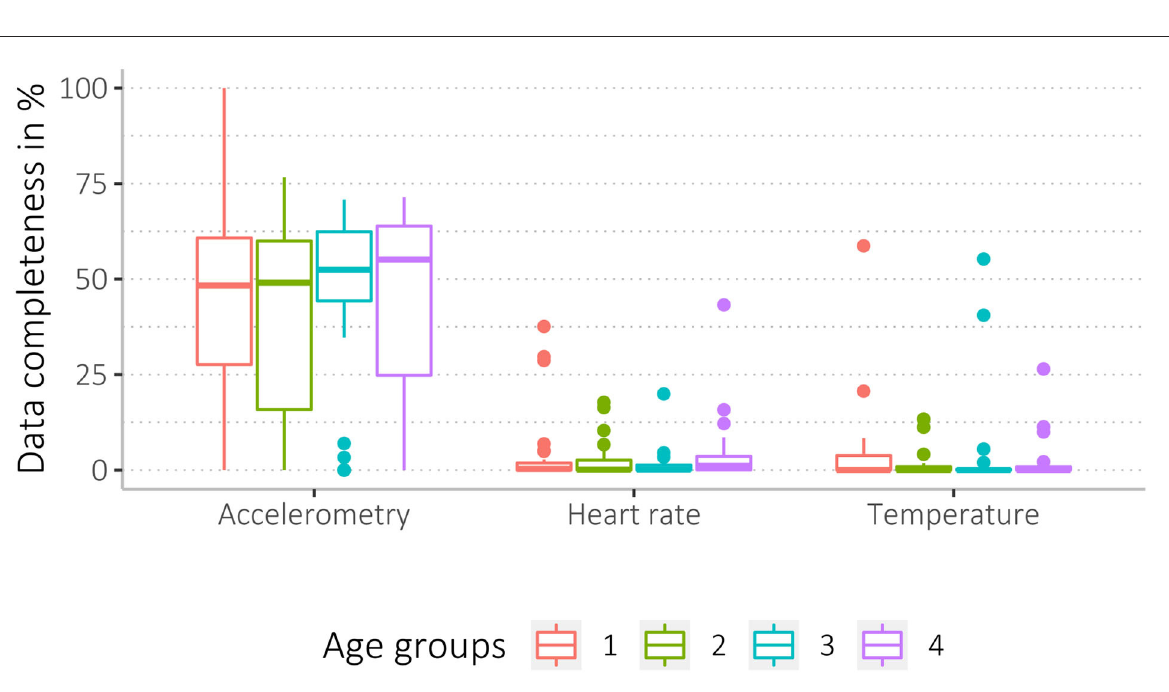
FIGURE6 Data completeness of the four age groups (6–16 yrs, 17–26 yrs, 27–42 yrs, and 43–84 yrs) regarding the three data sources (accelerometry, HR, and